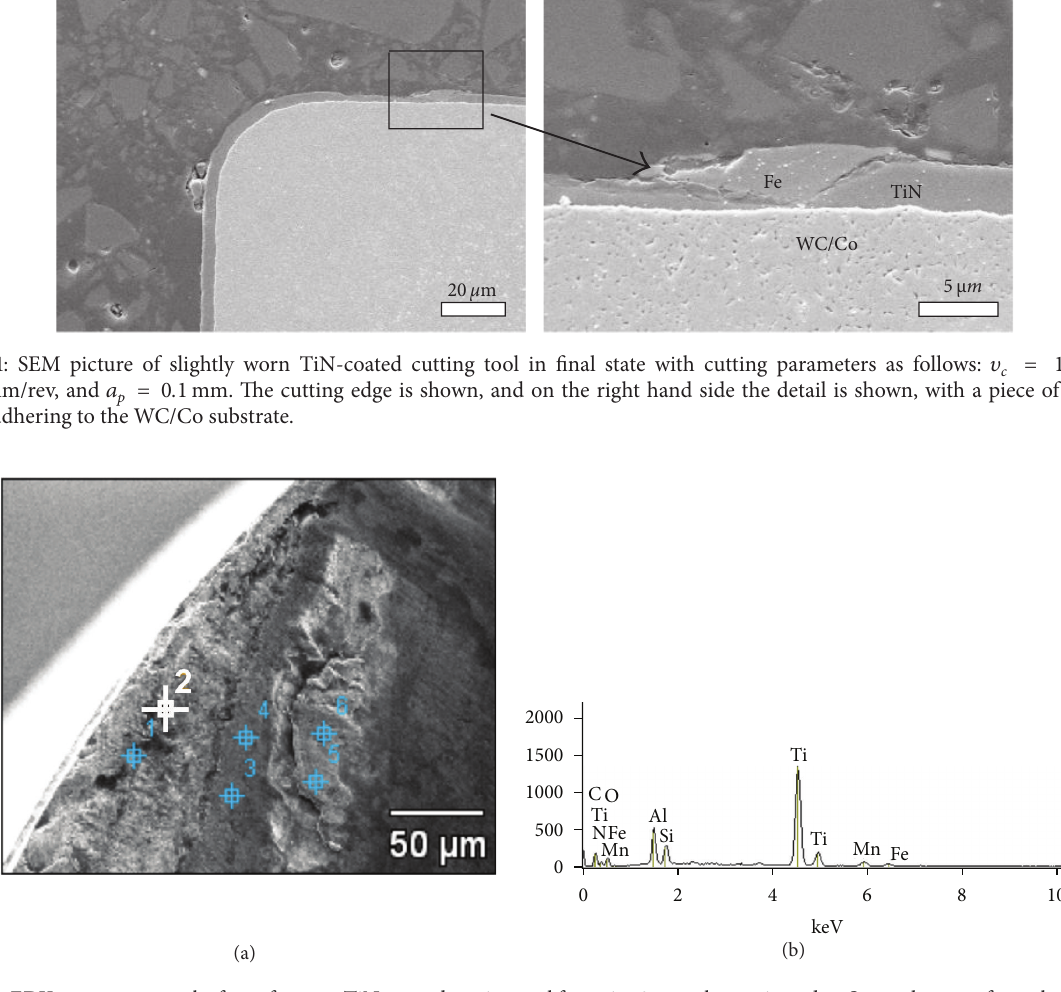
Figure 12: EDX spectrum on rake face of a worn TiN-coated cutting tool for point 2 near the cutting edge. Some elements from the workpiece material were found (cutting conditions: 𝑣 𝑐 = 150 m/min, 𝑓 = 0.2 mm/rev, and 𝑎 𝑝 = 0.1